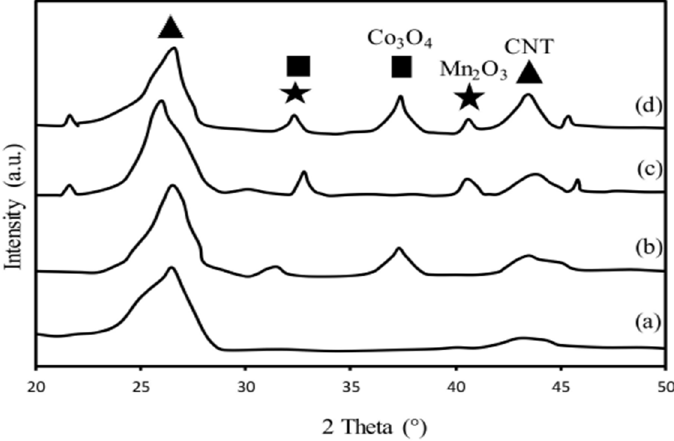
Figure 7. XRD patterns of ( a ) CNT ( b ) Co/CNT. A.T ( c ) Mn/CNT.A.T ( d ) 95Co5Mn/CNT.A.T catalysts.